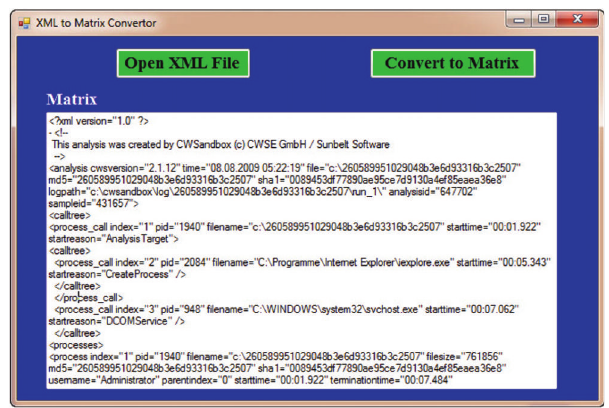
Figure 2: A snapshot of XML convertor to nonsparse